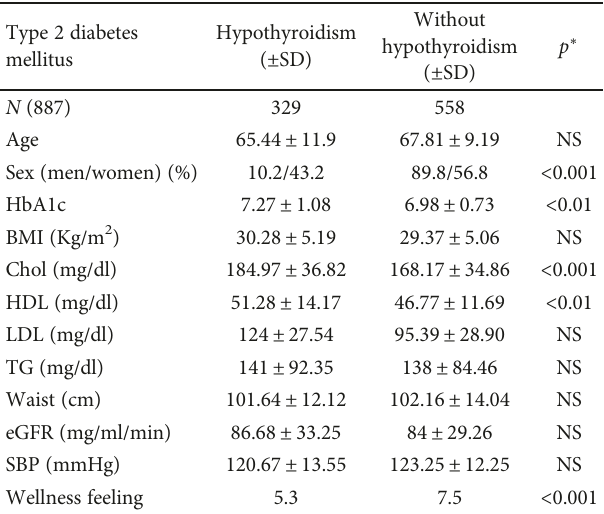
Table 3: Biochemical and anthropometric measurements in T2DM patients with and without